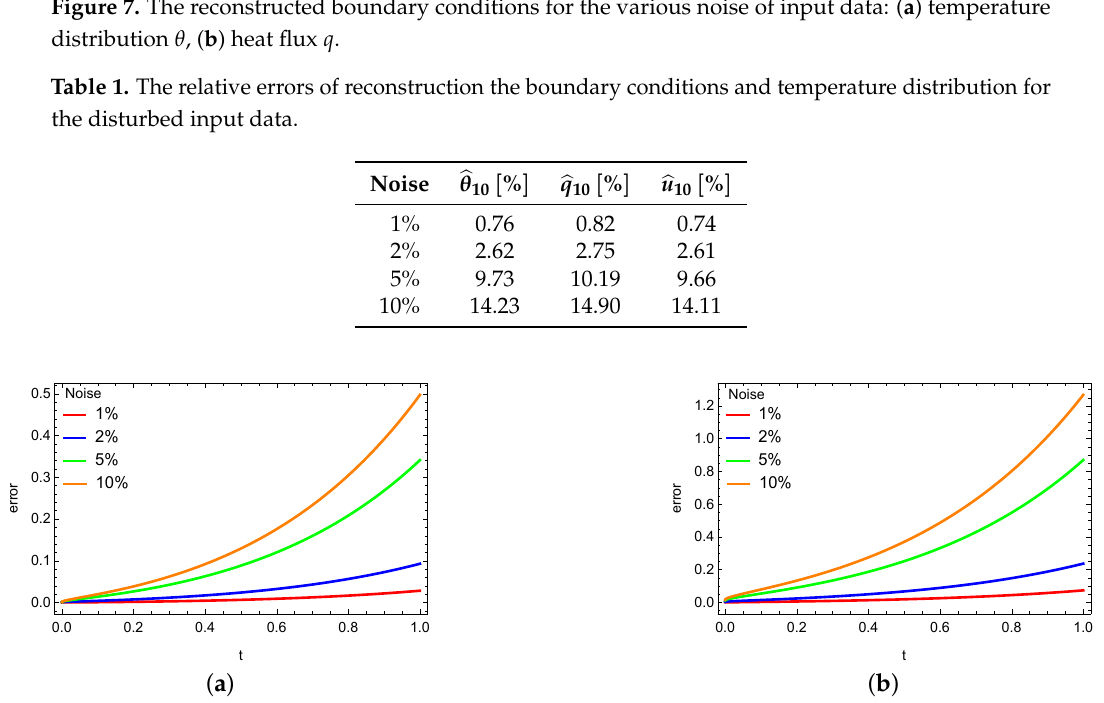
Figure 8. The absolute errors of the boundary conditions reconstruction for the various noise of the input data: ( a ) temperature distribution θ , ( b ) heat flux q